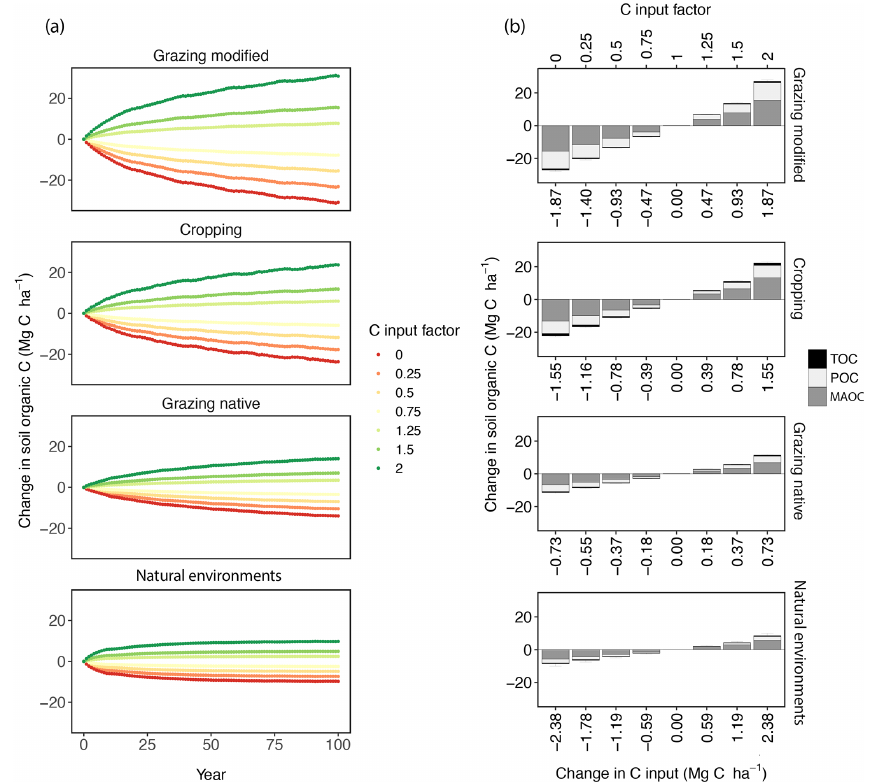
Figure 5. (a) The 100-year simulations showing the changes in total organic C (TOC) in the topsoil (0–0.3m) following changes in C input ( n = 4043). At each site, baseline C input was multiplied by the factor 0, 0.25, 0.5, 0.75, 1.25, 1.5 and 2 to derive different C input levels. (b) Median changes in TOC and its fractions, consisting of the particulate and mineral-associated organic C (POC and MAOC), calculated over the last 11 years of the simulation (at the new or near new equilibrium). Table 2. After 100-year simulations, median change (%) in the stocks of total, particulate and mineral-associated organic C (TOC, POC and MAOC) from baseline as a result of climate change, represented by temperature increases of 1.5, 2 and 5 ◦ C. Temperature Cropping Grazing Grazing Natural increase ( ◦ C) modified native